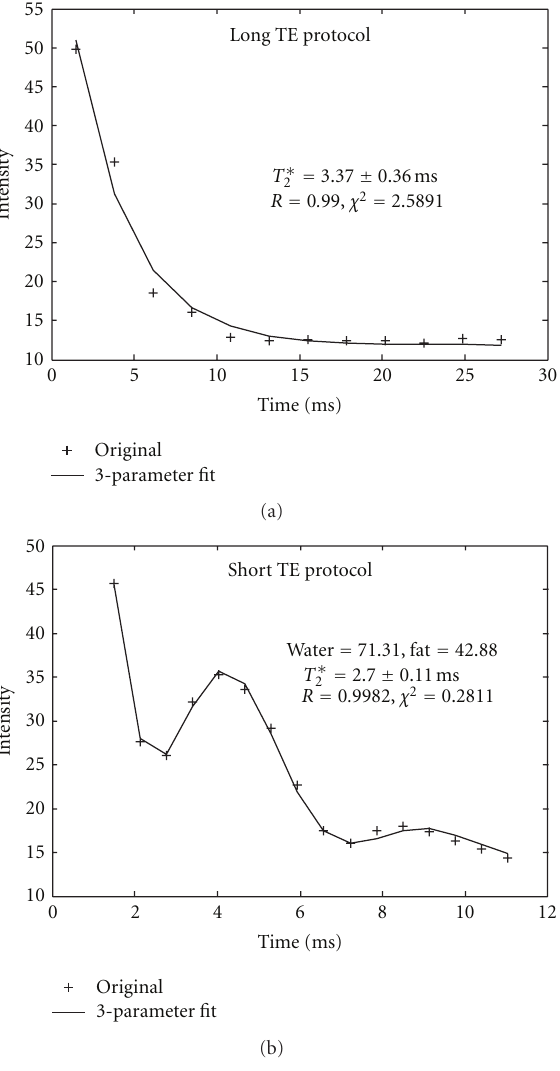
2 curve fit from a liver steatosis patient with short T ∗ 2 values and by dual acquisition method. (a) Data was acquired by the long TE protocol. The water and fat peaks were totally missed because data was sampled too slowly. (b) The same patient data was acquired by the short TE protocol with faster sample (shorter Δ TE). Water and fat peaks were caught and data was fitted with water and fat components. Again data acquired by the short TE protocol generated better fit for short T ∗ 2